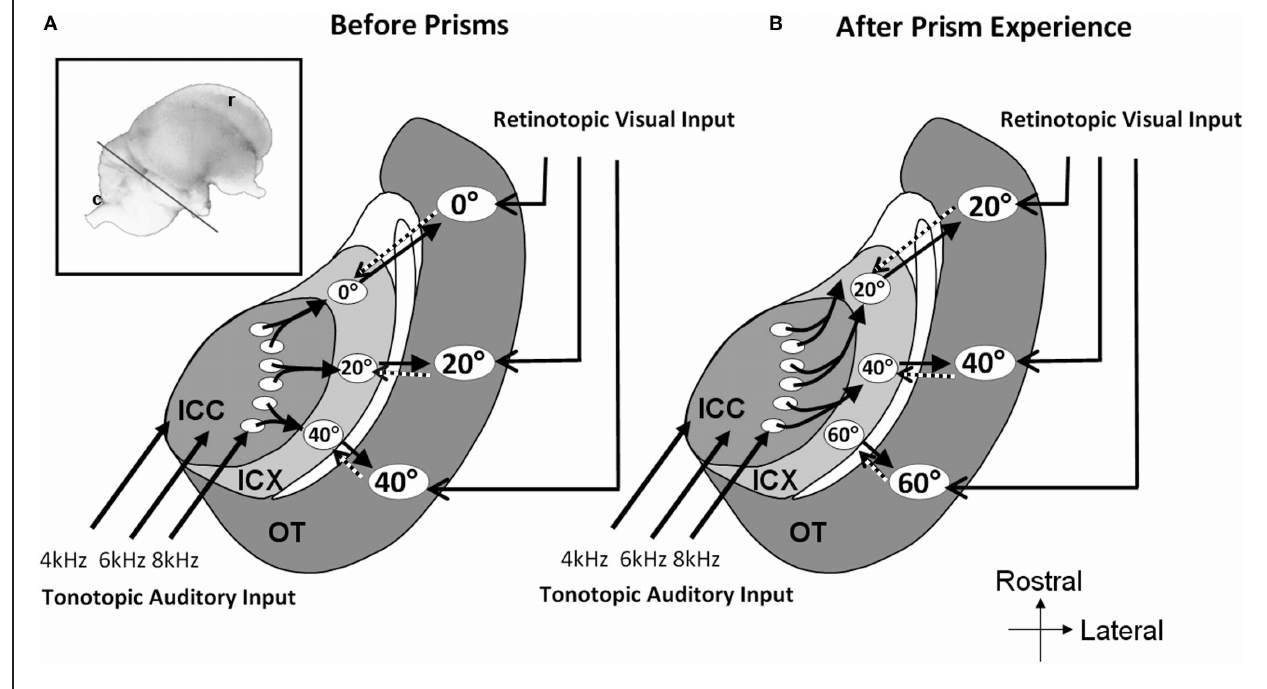
FIGURE 8 | Schematic representation of the mid-brain auditory localization pathway in normal and in prism-reared owls. The inset shows a lateral view of the barn owl’s brain. The line marks the approximate plane of the section through the tectal lobe illustrated schematically in A and B . (A) Information flows from the central nucleus of the inferior colliculus (ICC) to the external nucleus of the inferior colliculus (ICX) and from there to the optic tectum (OT). A map of auditory space is created in ICX. This map joins the visual retinotopic map arriving from the retina and forebrain in OT. Topographic connections from the OT to the ICX